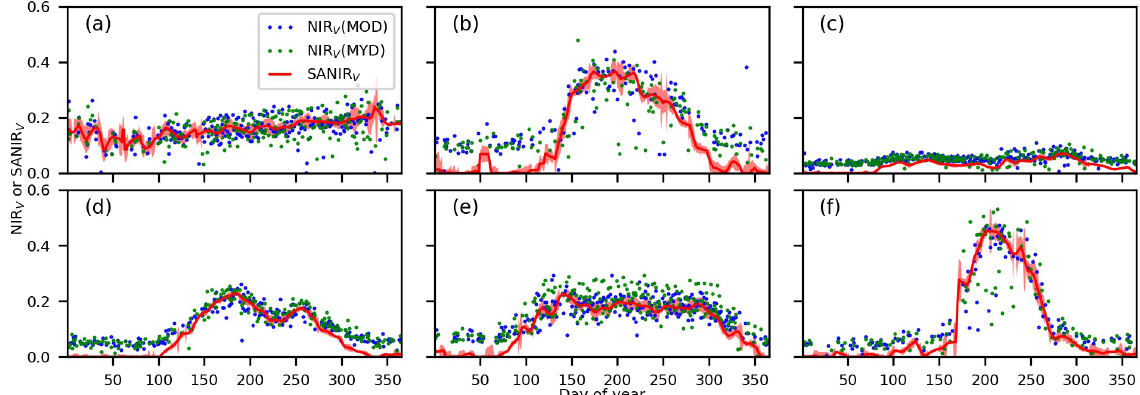
Figure 6. Comparison between SANIR V and raw NIR V derived from MOD09GQ and MYD09GQ products at six AmeriFlux sites (Table S3) in 2019. (a) US-Blo (evergreen needleleaf forest, ENF). (b) US-Ha1 (deciduous broadleaf forest, DBF). (c) US-Whs (open shrubland, OSH).